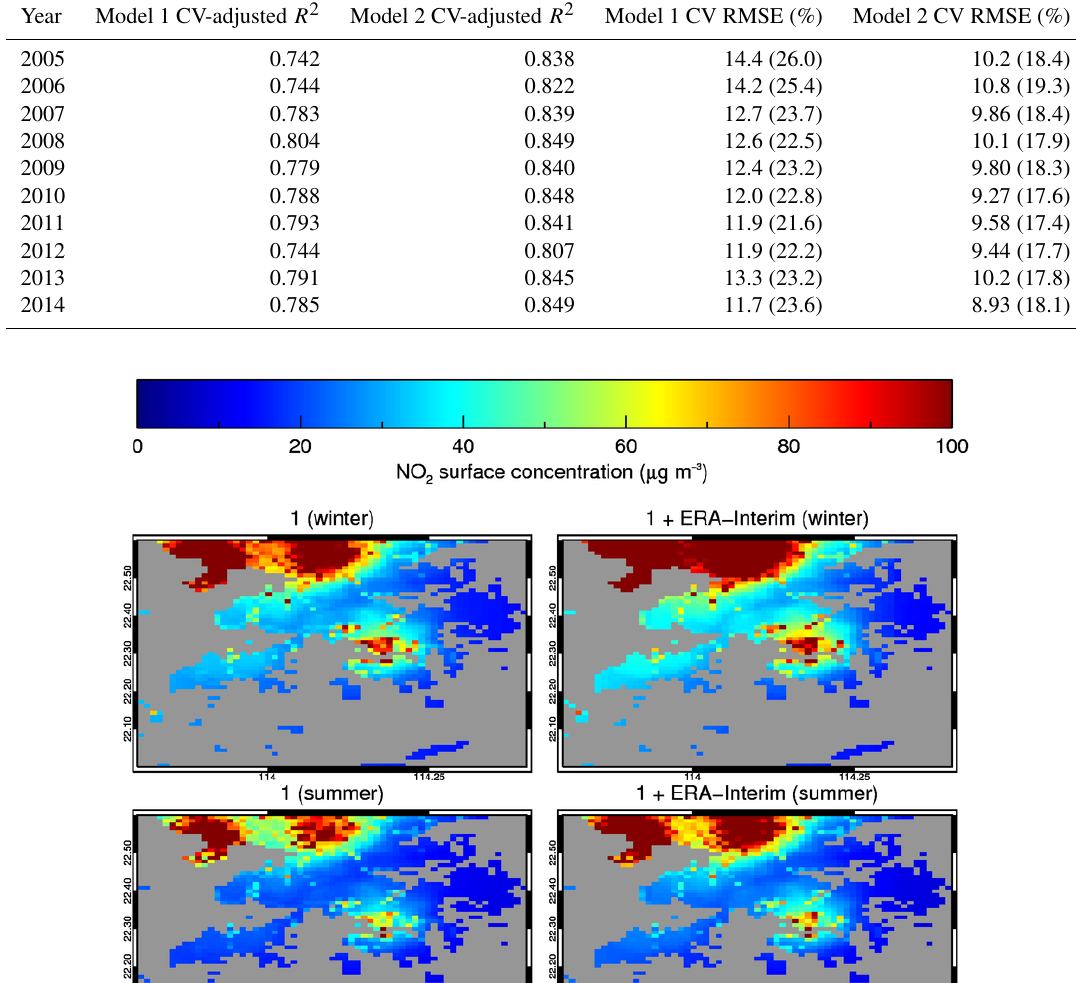
Table 5. The adjusted R 2 and RMSE (µgm − 3 ) determined from the 5-fold cross-validation (CV) applied to models 1 and 2 (see Tables 2 and 4), grouped by year.